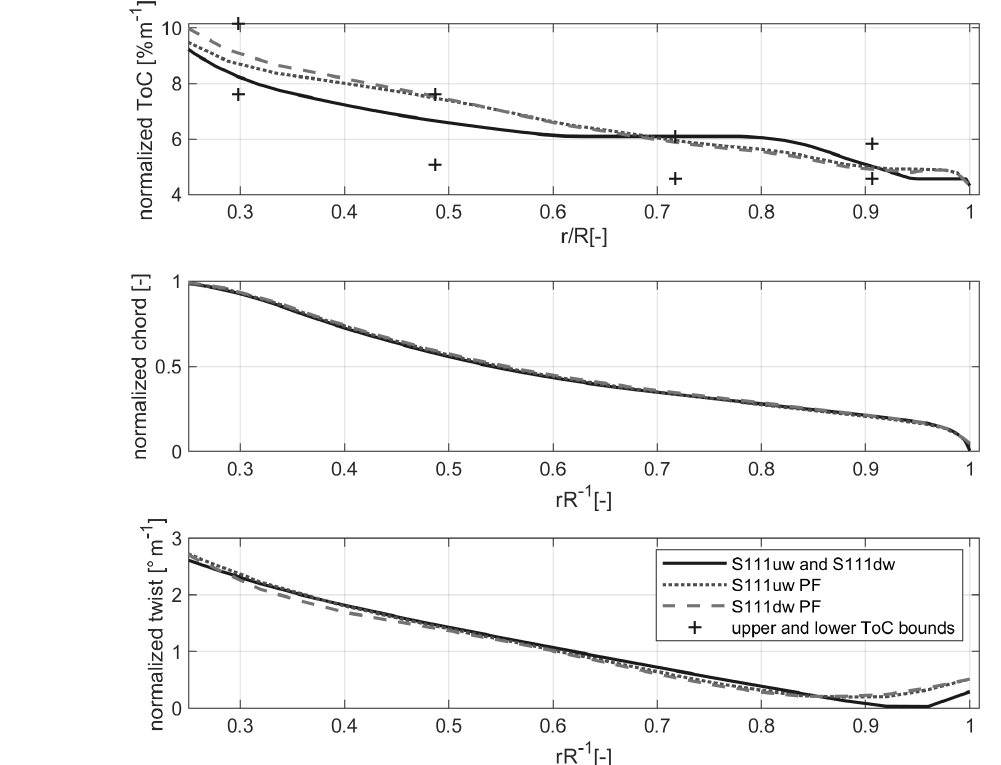
Figure 5. Comparison of planforms for different designs. Thickness over chord ratio and the range of the thickness constraints, chord and twist are normalized with the maximum